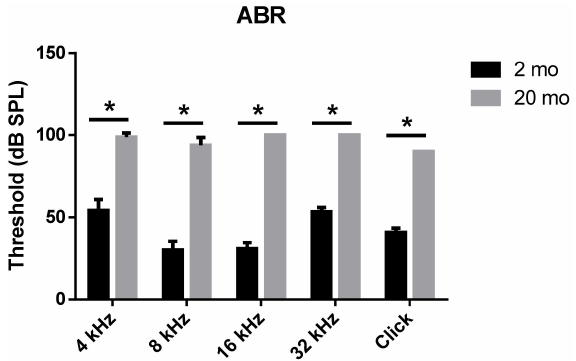
Figure 1. Aged mice displayed greater hearing loss as compared to young animals. ABR Table; 2-month- or 20-month-old male C57BL / 6J mice. Aged mice exerted a significantly increased ABR threshold compared to young mice at all frequencies and click sound. The graph represents mean ± S.E.M. t -test. * p < 0.0001. n = 6, 2 months; n = 4, 20